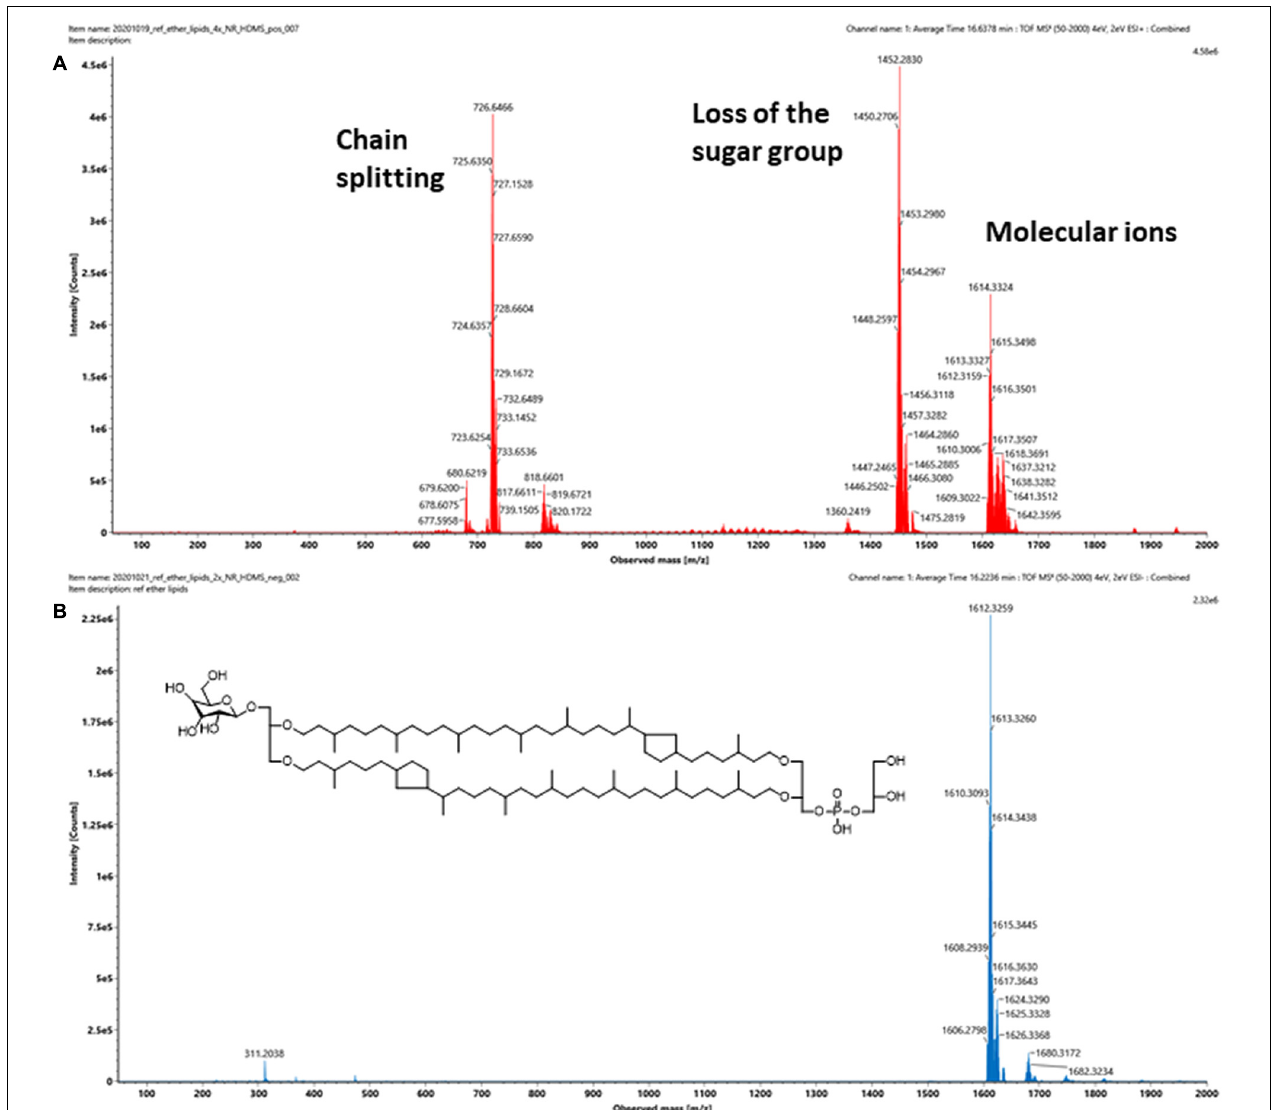
FIGURE 5 | (A) Positive and (B) negative ion mass spectra of a commercially available intact polar GDGT reference standard that contains a mixture of at least five β -L-gulopyranosyl-caldarchaetidyl-glycerols. Insert shows the chemical structure of the major component, which contains two cyclopentane rings. The number of spectral features detected is typically a lot higher than the number of lipids in a sample. The challenges associated with the formation artifacts could also be avoided or circumvented in negative mode, as uncomplicated mass spectra of intact GDGTs could be